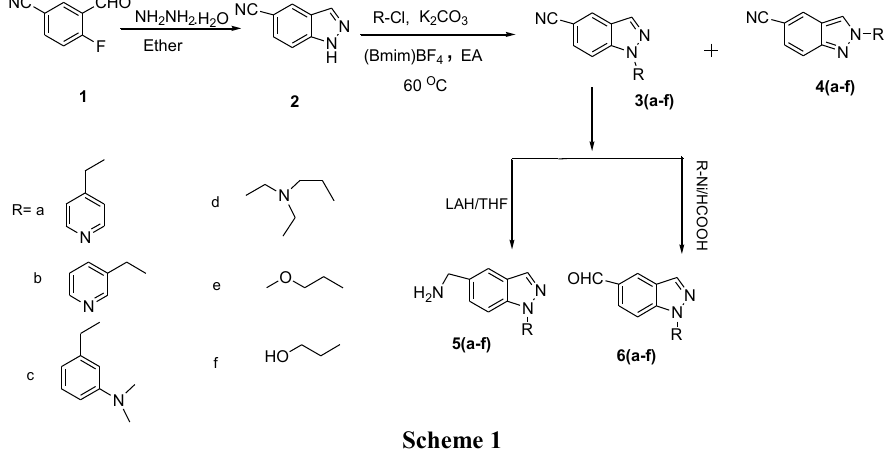
Table 1. Alkylation of 5-cyano-indazole 2 under (Bmim)BF Catalyst